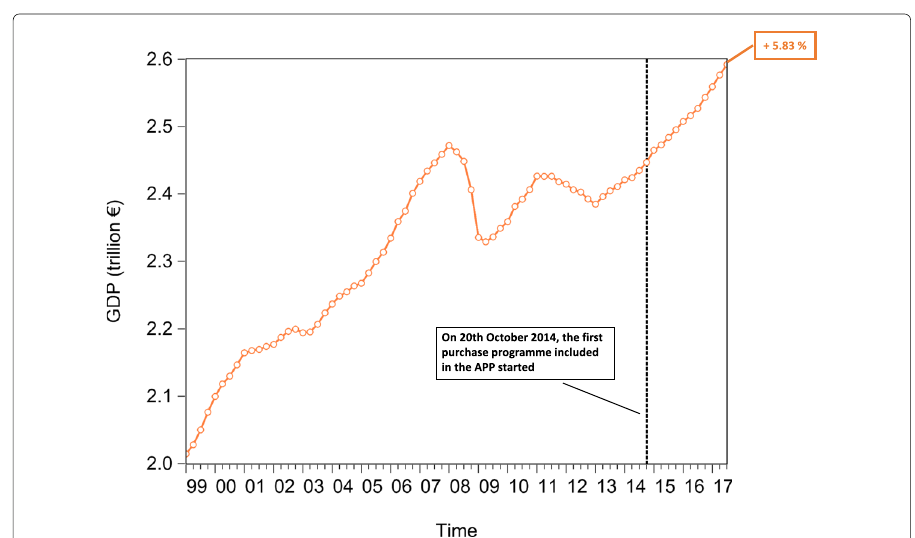
Fig. 18 Euro area GDP; 1999Q1-2017Q2. Time series of the euro area Gross Domestic Product (GDP) at market prices, over the reference period 1999Q1-2017Q2. The vertical line corresponds to the beginning of the first purchase programme (3rd Covered Bond Purchase Programme, CBPP3) included in the APP, started in 2014Q4, while the percentage on the right-hand side of the graph corresponds to our estimate of the growth rate of euro area GDP, since the initiation of QE. Data source: (European Central Bank